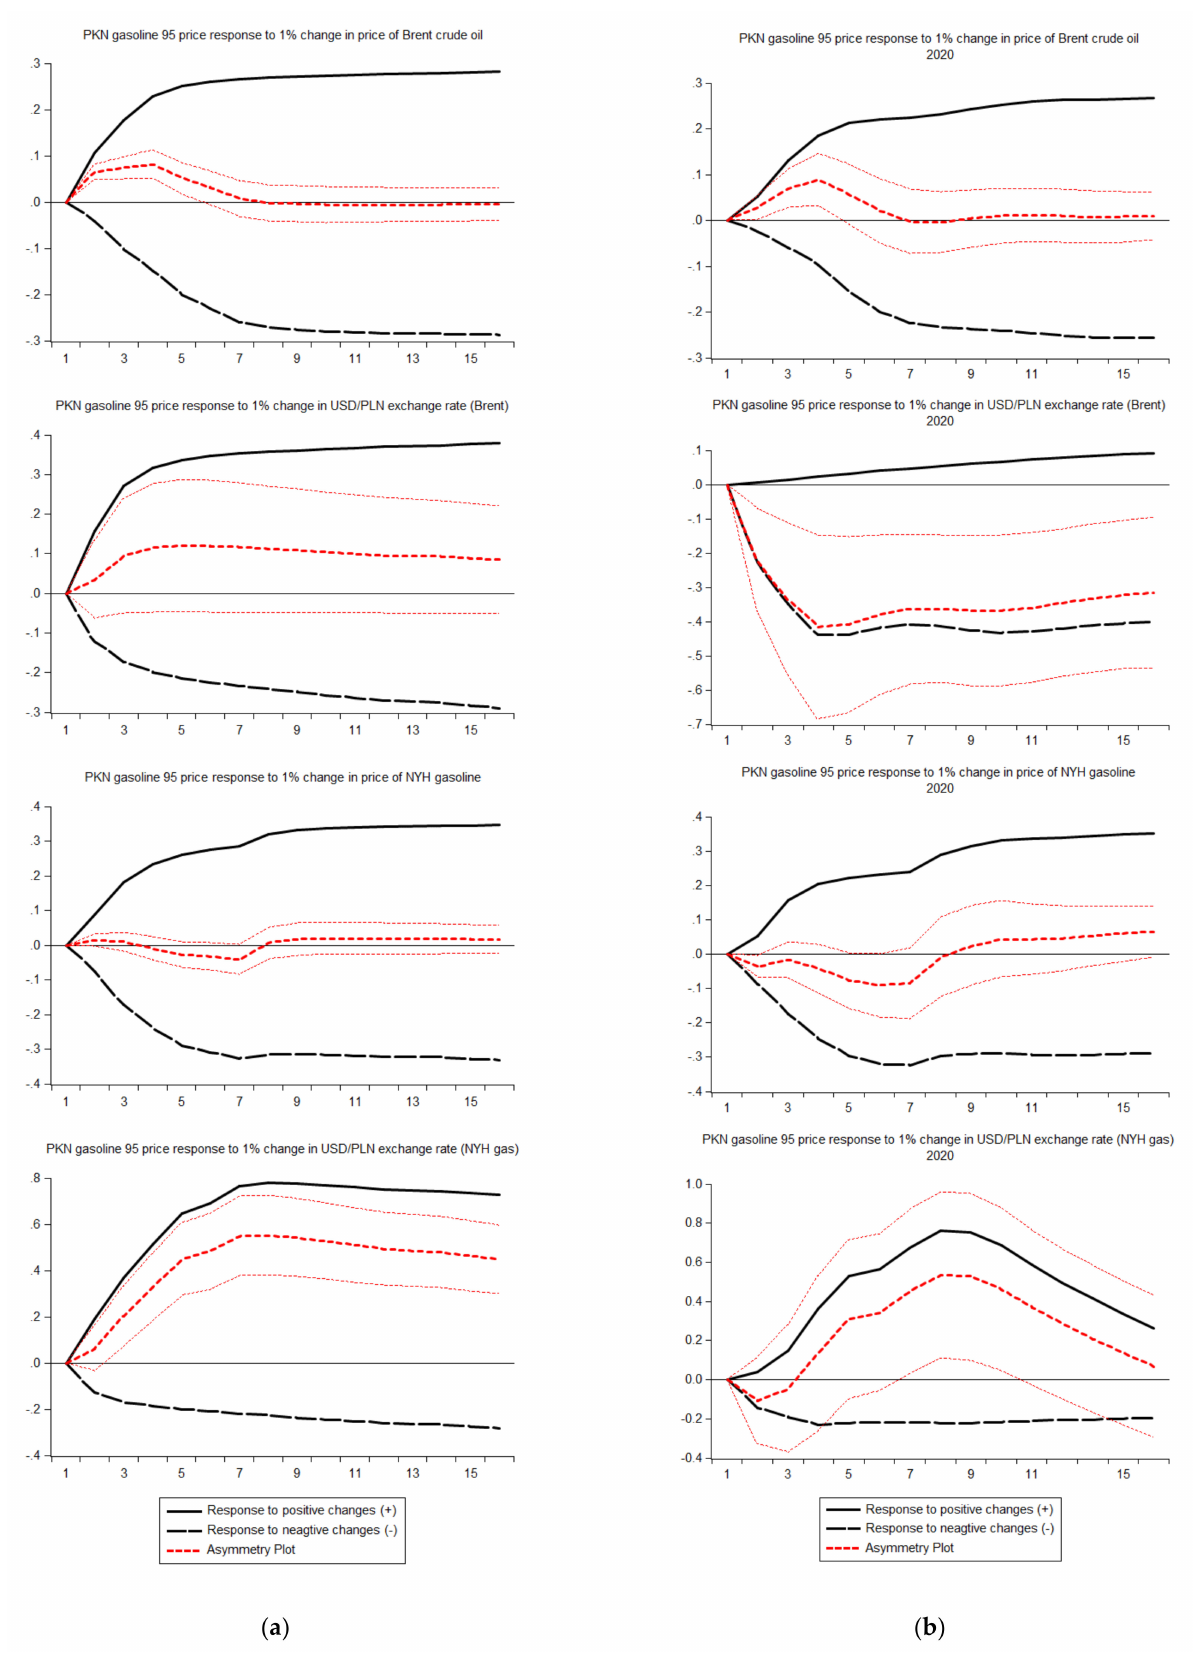
Figure 10. Dynamic multipliers for PKN Orlen Gasoline 95 ( a ) whole sample; ( b ) year